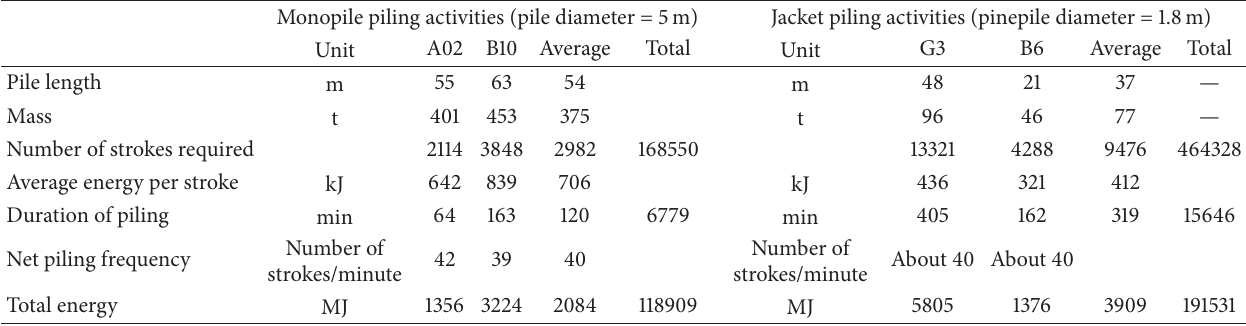
Table 2: Summary statistics of the piling activities of monopile A02 and B10 and jacket foundations CB6 and CG3, targeted in this study, as well as the averages and total (where appropriate) for the 56 monopiles installed at the Blighbank (source: Belwind) and the 49 jacket installed on the Thorntonbank (source: